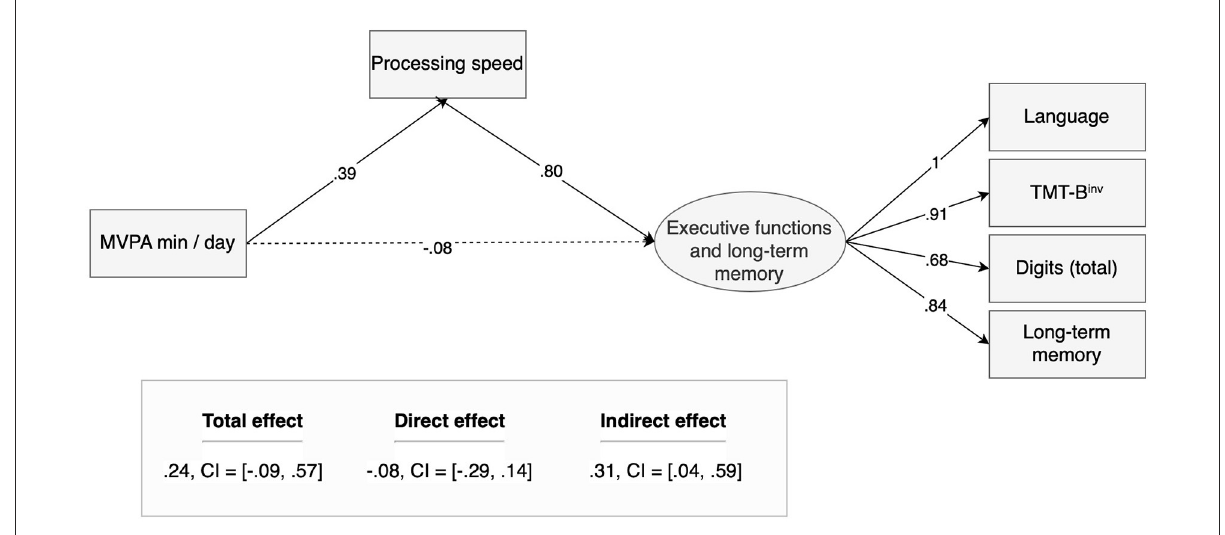
FIGURE1 The mediation model of the effect of MVPA on executive functions and long-term memory through processing speed.